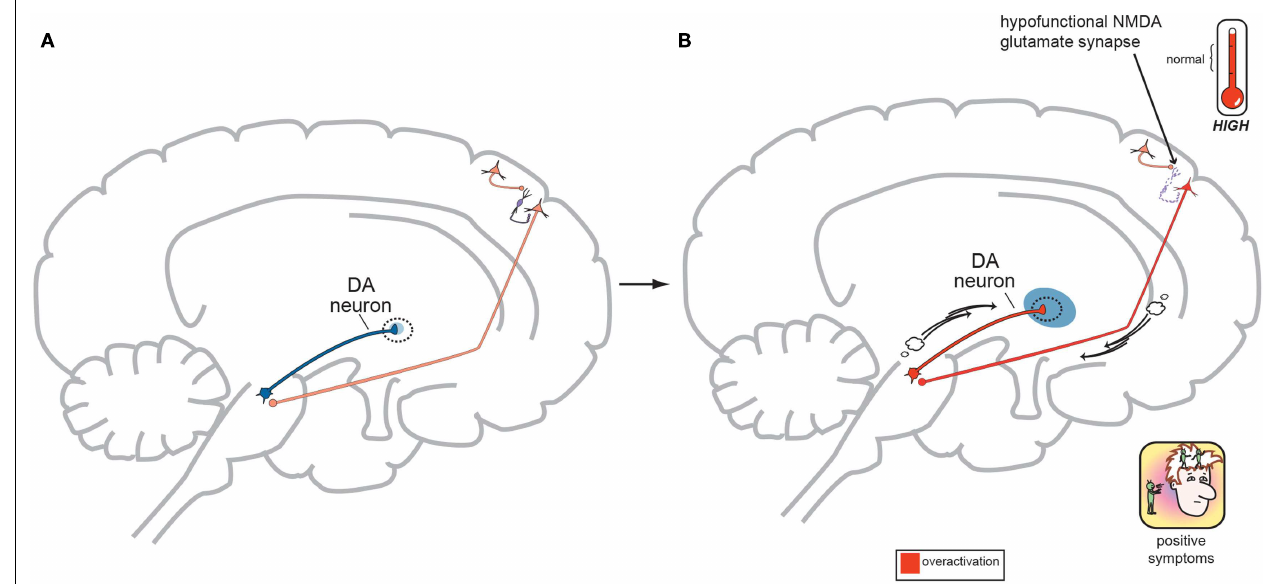
FIGURE 4 | (A) Normal GLU-GABA-GLU-DA Neuronal Circuitry.The cortical brainstem glutamate projection starts in the frontal cortex as the top most neuron and leads ultimately to the deeper mesolimbic dopamine pathway. However, this sequence of neurons consists of several stops making a neurocircuit loop. Normally, a fully functioning primary GLU neuron (top most pyramidal neuron) fires upon a smaller GABA interneuron which next releases inhibitory GABA onto a secondary GLU pyramidal neuron (which now is the third neuron in the series from the top) causing it to lower its firing rates.This loss of GLU tone at this second GLU neuron is normal. The fourth neuron is dopaminergic and fires at a normal rate and without positive psychotic symptoms.When this circuit is optimal or controlled it avoids generation of positive schizophrenia symptoms allowing the correct amount of DA activity to occur.This creates a normal GLU-GABA-GLU-DA neurocircuit loop responsible for maintaining an appropriate, non-psychotic state. (B) Abnormal GLU-GABA-GLU-DA Neuronal Circuitry and the